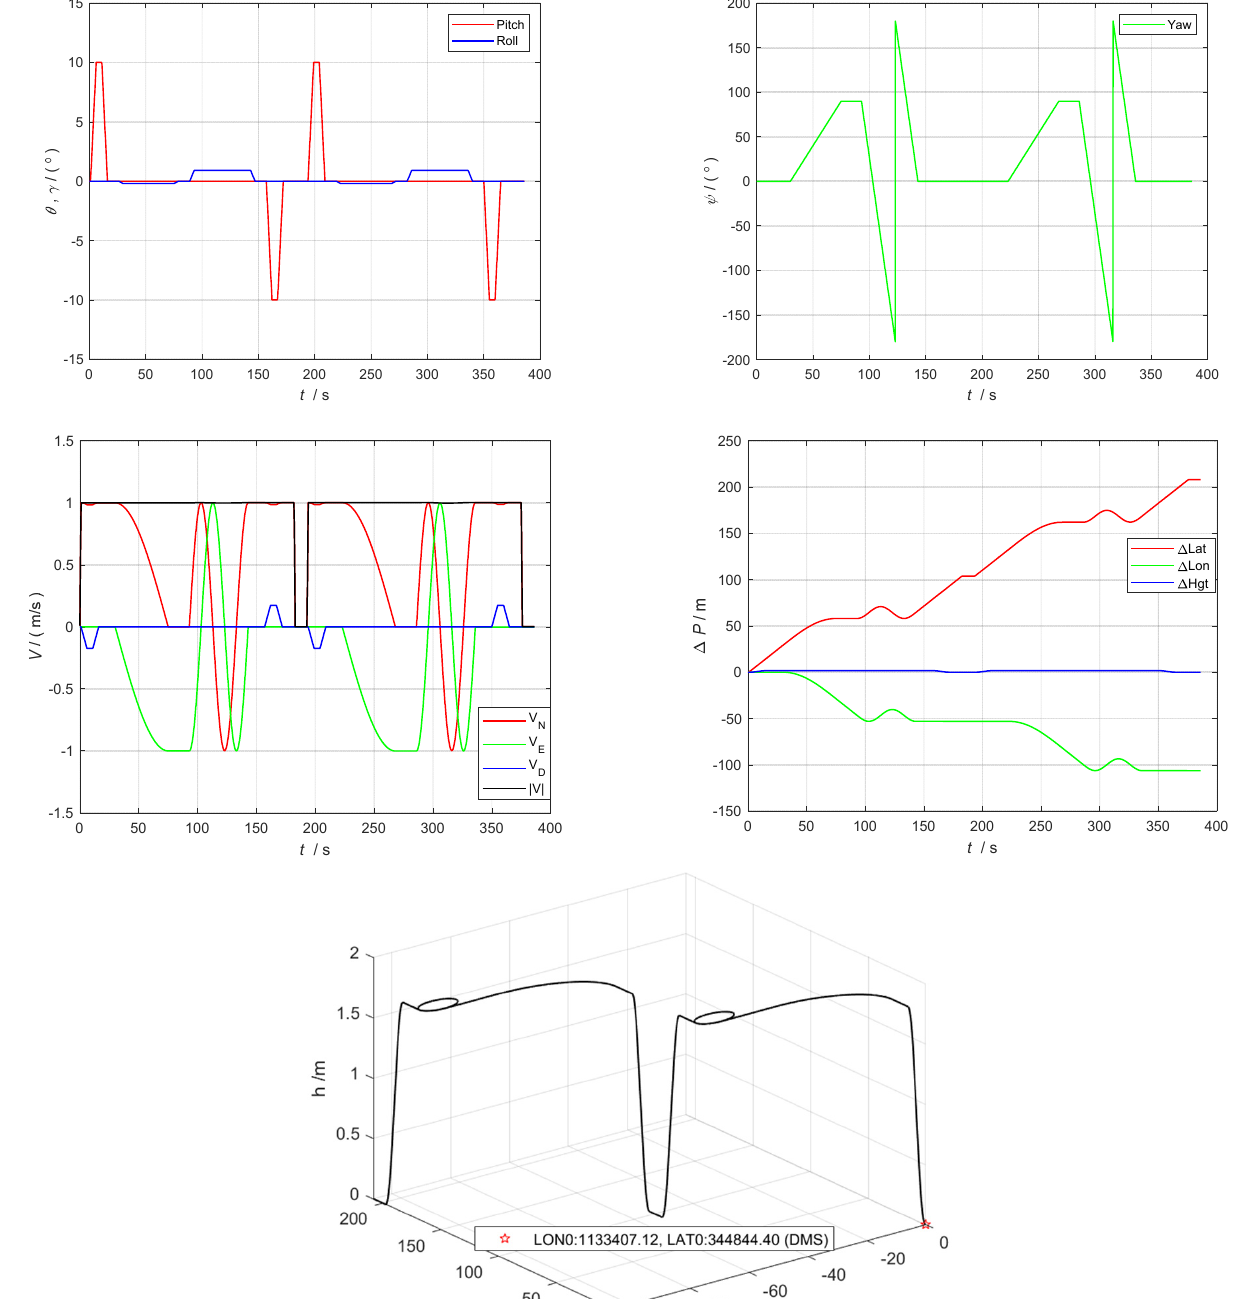
Figure 5. Trajectory and parameter state